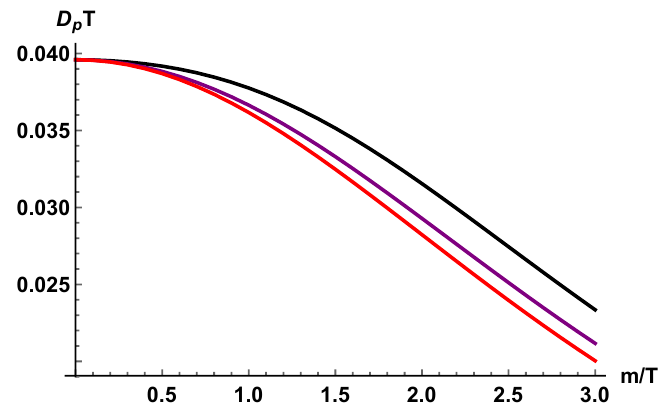
Figure 7 . The di(cid:11)usion constant of the sound mode, D p , obtained from (cid:12)tting the numerical data as a function of m=T for various potentials N = 3 ; 4 ; 5 (from black, top; to red,